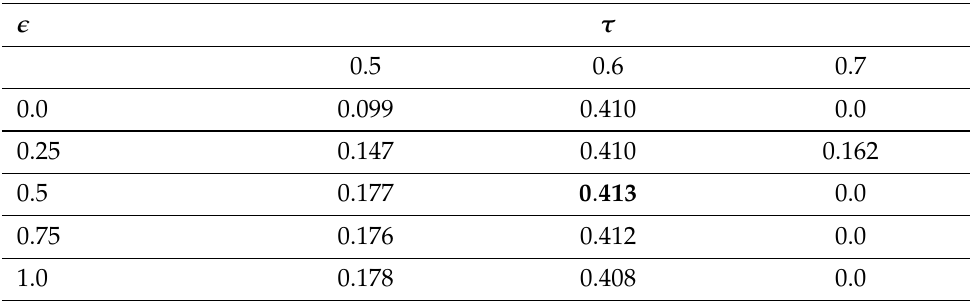
Table 4. F1-scores of ABIForest consisting of T = 150 trees as a function of the hyperparameters τ and (cid:101) for the Normal dataset with ω = 20.